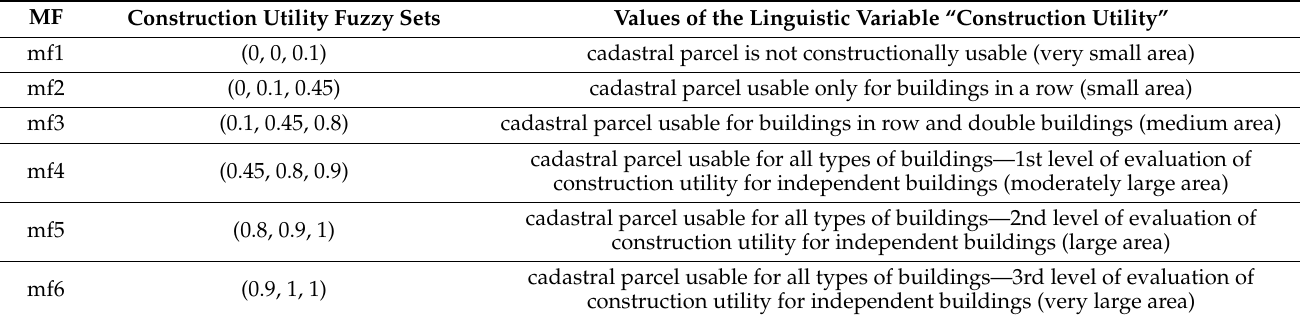
Table 4. Defining fuzzy sets and values of the linguistic variable “Construction utility”. MF